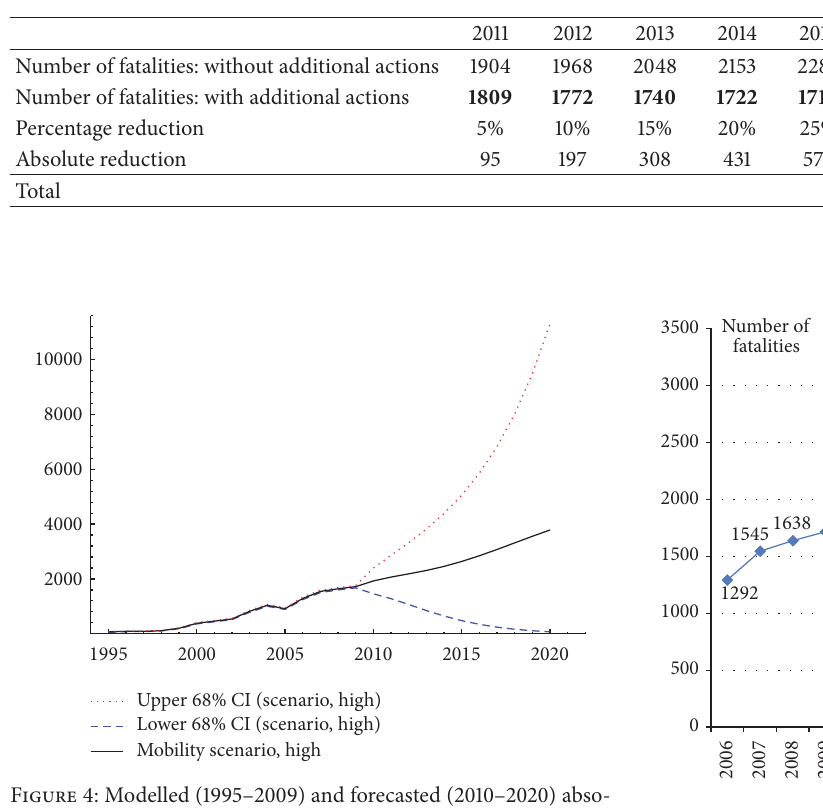
Table 7: The estimated number of fatalities in Cambodia with and without additional actions in 2011–2020.